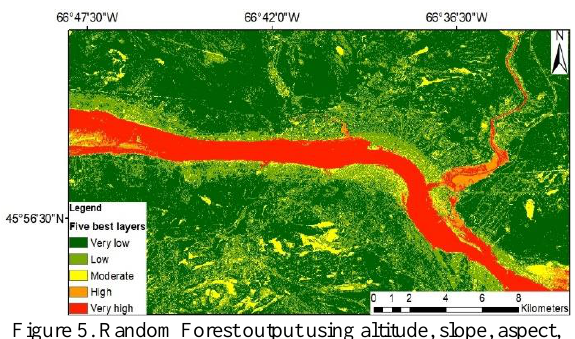
Figure 5. Random Forest output using altitude, slope, aspect,